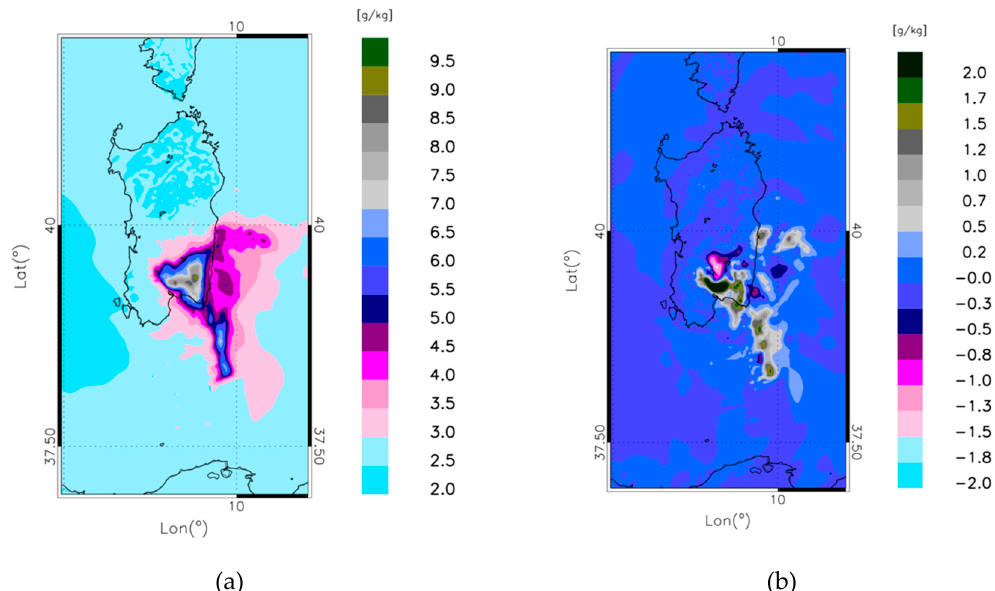
Figure 10. ( a ) Averaged water vapor between 3 and 10 km for VSF_1h (a zoom over Sardinia is provided for clarity) at 22 UTC on 10 October 2018; ( b ) difference between the averaged water vapor of VSF_1h and VSF_2km at the same date and time. The averaged water vapor between 3 and 10 km of VSF_2km was interpolated, using bilinear interpolation, onto the 3 km grid used by VSF_1h.